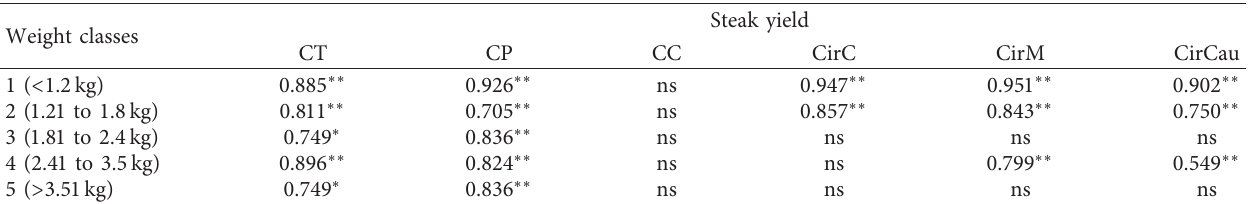
Table 5: Correlations between the steak yield and morphometric measurements in relation to the different weight classes of black pacu ( Colossoma macropomum